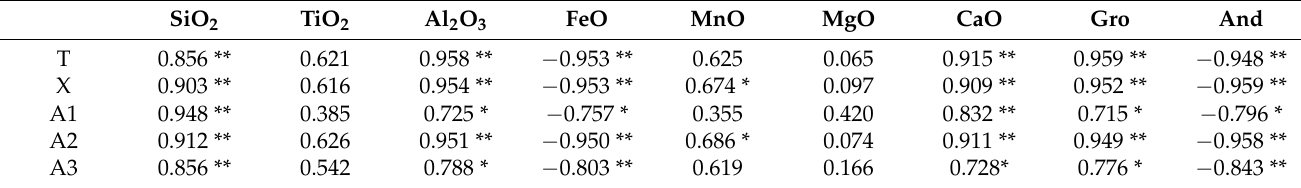
Table 4. Correlation